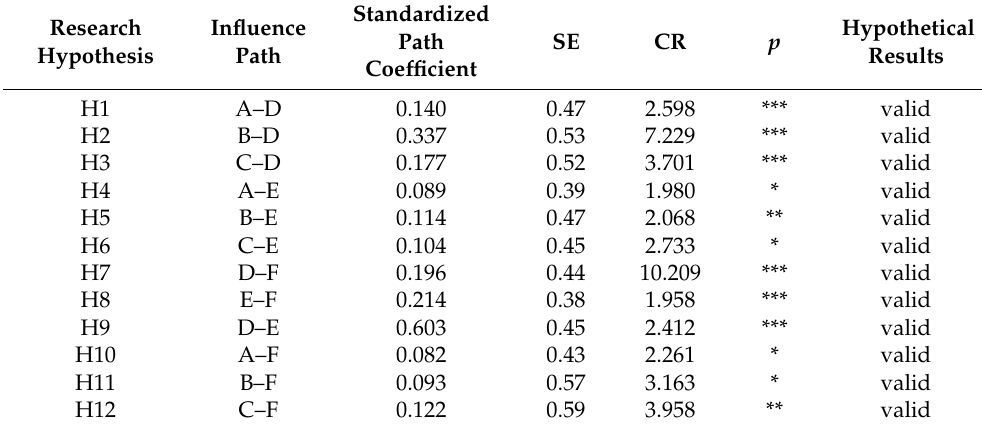
Table 5. Model hypothesis testing.